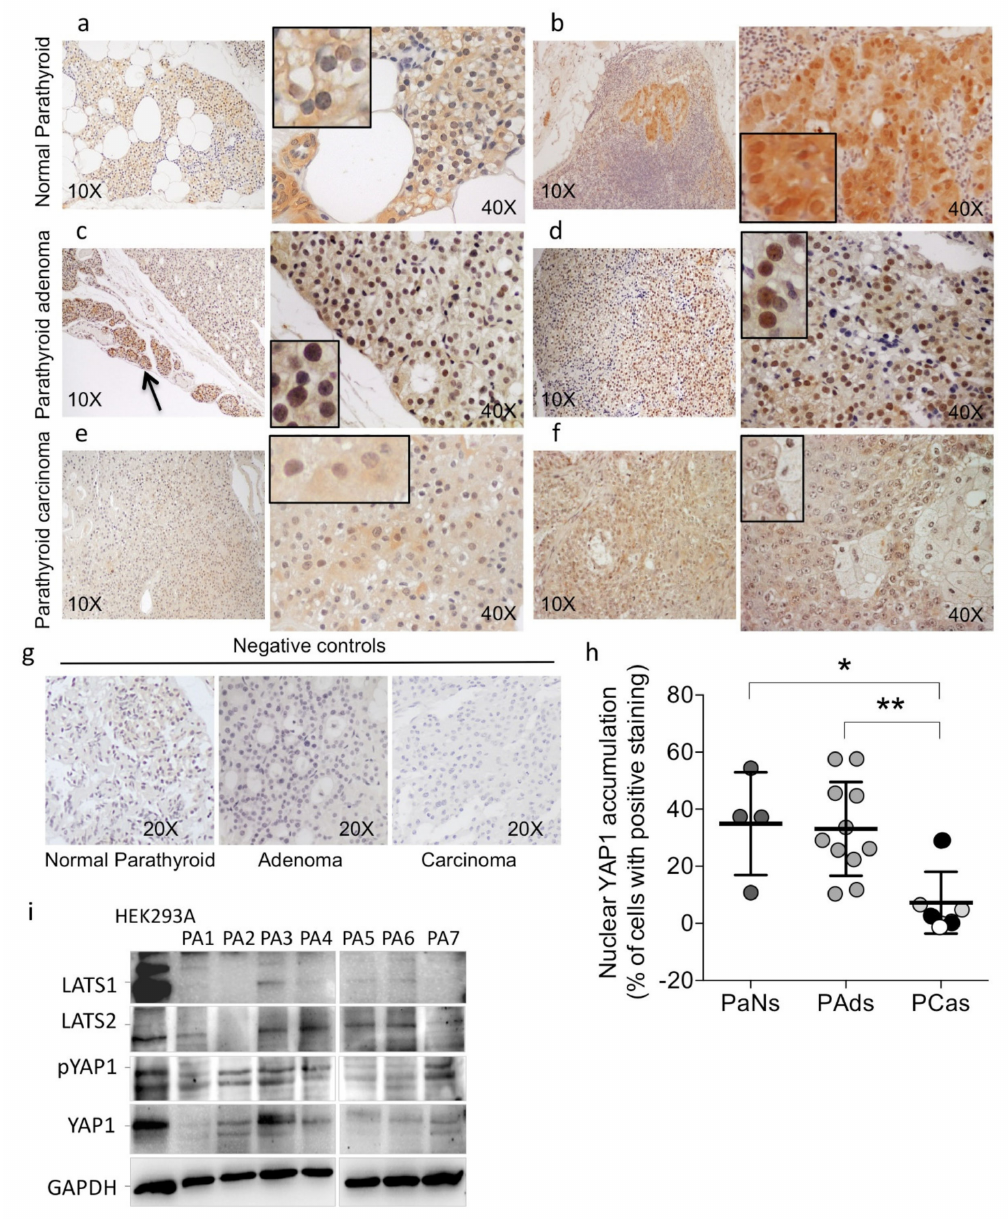
Figure 1. Expression of the Hippo pathway members Yes-associated protein 1 (YAP1) and LATS1/2 (large tumor suppressor 1/2) in parathyroid tissues. Immunohistochemistry analysis for total YAP1. Representative images showed immunostaining in normal parathyroid glands from normocalcemic patients ( a , b ), benign parathyroid adenomas ( c , d ), parathyroid carcino- mas ( e , f ). ( c ) Black arrow indicates normal parathyroid cells of the parathyroid gland rim surrounding the parathyroid adenoma. ( e ) Section of parathyroid carcinoma from a patient harboring a germline inactivating multiple endocrine neoplasia type 1 (MEN1) gene mutation. Magnifications are indicated in each panel; the inserts show enlarged details. ( g ) Negative controls. ( h ) Quantification of nuclear YAP1 staining as a percentage of positive parathyroid cells; each dot is a case; lines, mean, and SD; PaNs, parathyroid normal glands from normocalcemic patients; PAds, parathyroid benign adenoma; PCas, parathyroid carcinoma; black or grey circles, PCas harboring cell division cycle 73 (CDC73) or MEN1 inactivating mutations, respectively; white circle, PCa harboring CDC73 and MEN1 wildtype alleles; *, p = 0.024; **, p = 0.012 by one-way ANOVA corrected for multiple comparisons. ( i ) Western blot analysis of LATS1, LATS2, phosphorylated YAP1, and total YAP1 expression, in total protein extracts from a series of seven parathyroid adenomas (PA), compared with total protein extracts from human embryonic kidney 293A (HEK293A) cells. GAPDH was a loading